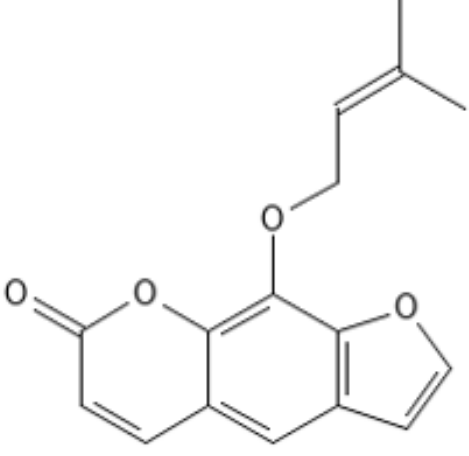
Figure 1. Chemical structure of imperatorin.